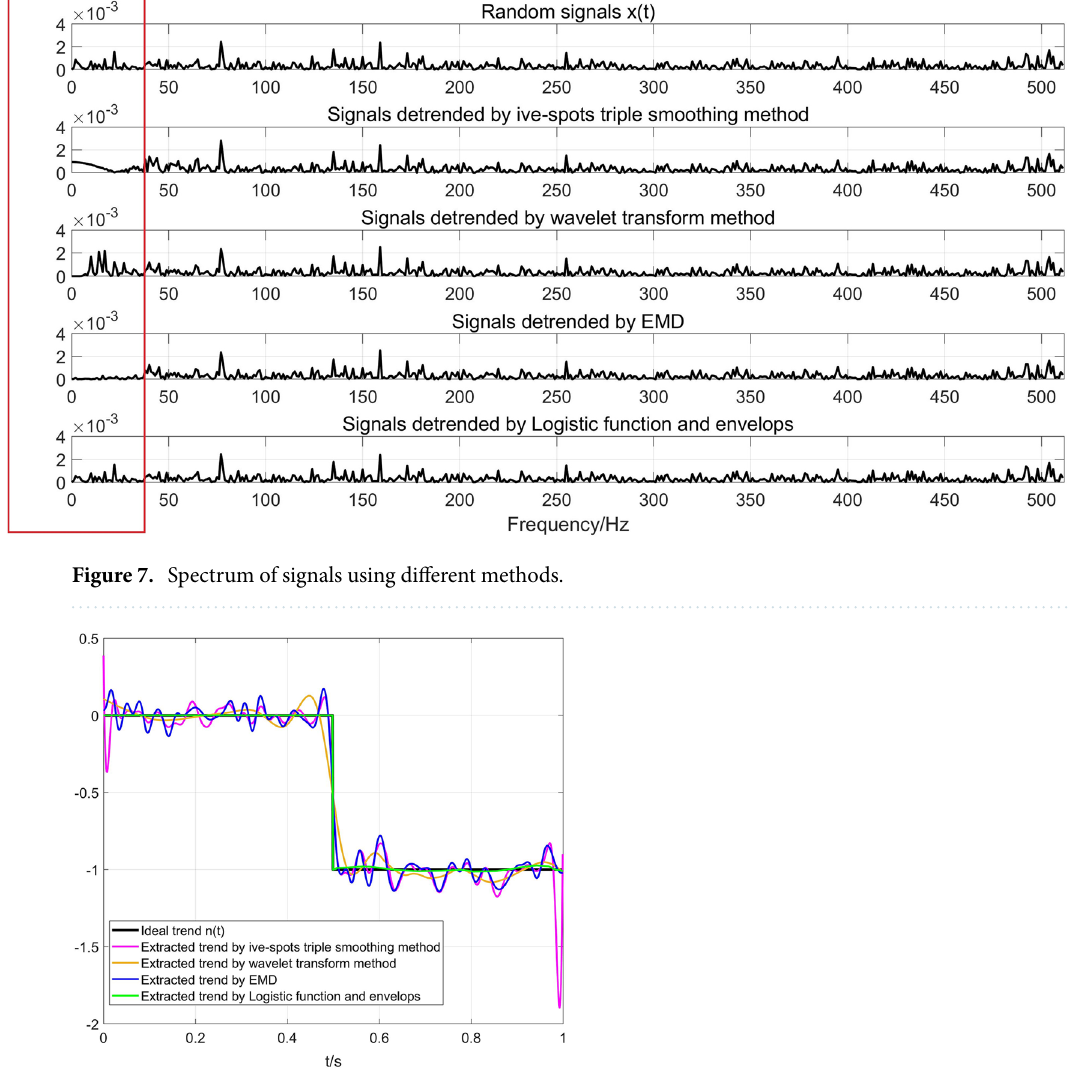
Figure 8. Extracted trend using different methods.